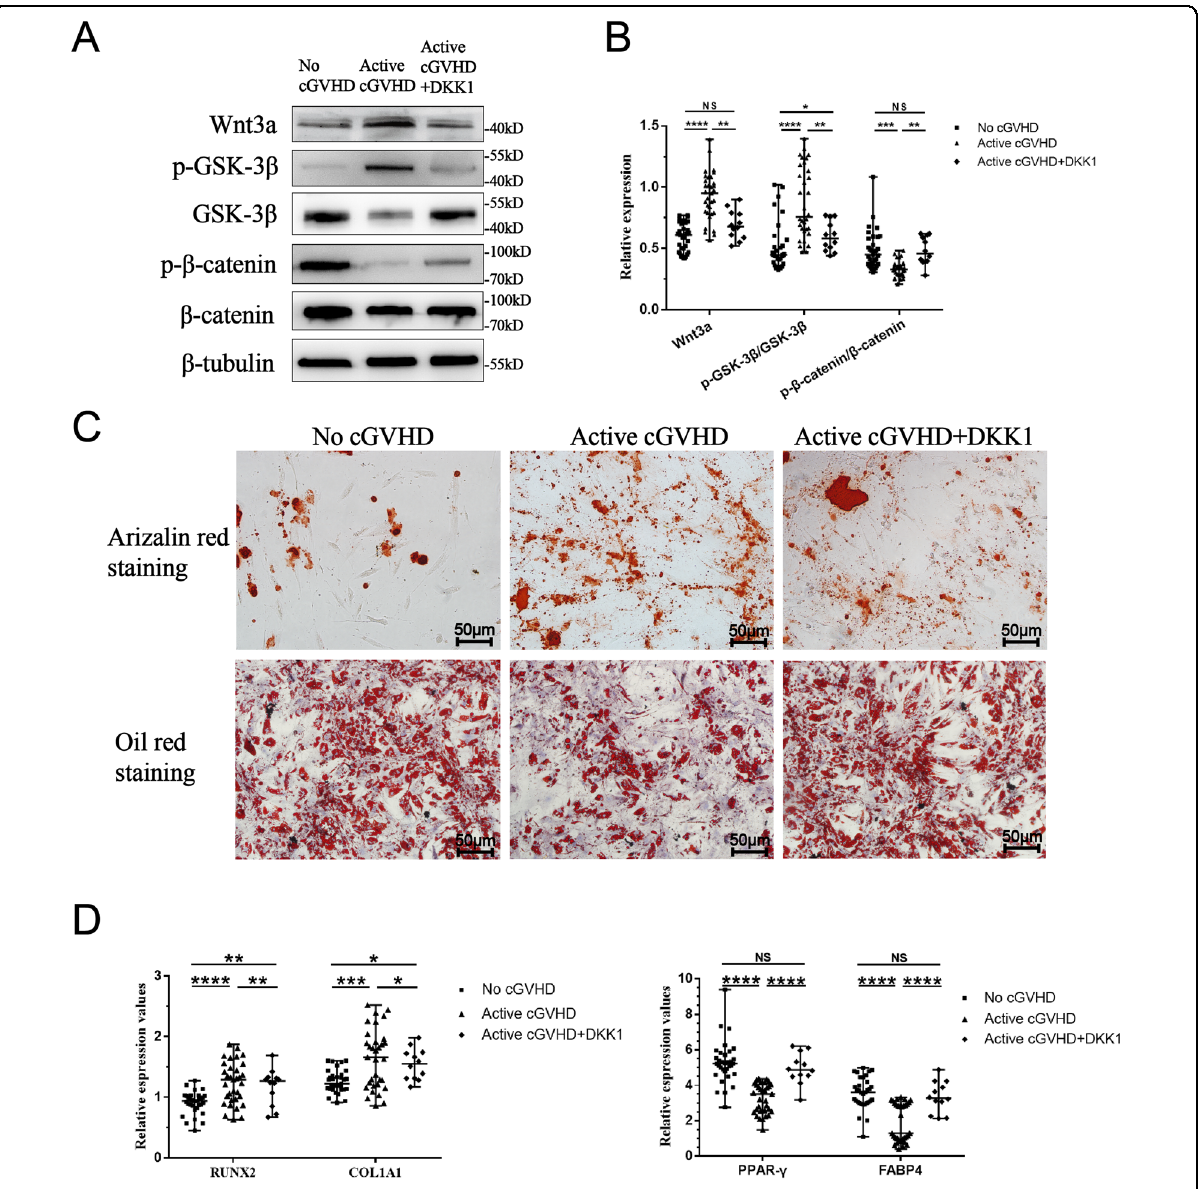
Fig. 5 DKK1 decreased the expression of Wnt/ β -catenin signaling in active cGVHD-MSCs. A Representative protein expression of Wnt3a, phosphor-GSK-3 β , total-GSK-3 β , phosphor- β -catenin, total- β -catenin, and β -tubulin in active cGVHD-MSCs treated or untreated with DKK1 ( n = 12) and no cGVHD-MSCs ( n = 12). B Relative protein expression of active cGVHD-MSCs treated or untreated with DKK1 ( n = 12) and no cGVHD-MSCs ( n = 12). C Relative gene expression of osteogenic/adipogenic marker gene. D Alizarin red staining, Orange-red represents calcium nodules. Oil Red O staining, red represents lipid droplets. No cGVHD-MSCs ( n = 33), active cGVHD ( n = 33) and DKK1 + cGVHD ( n = 12). Black bars in each fi gure represent the median ± range. NS, not signi fi cant. * P < 0.05, ** P < 0.01, *** P < 0.001, and **** P <